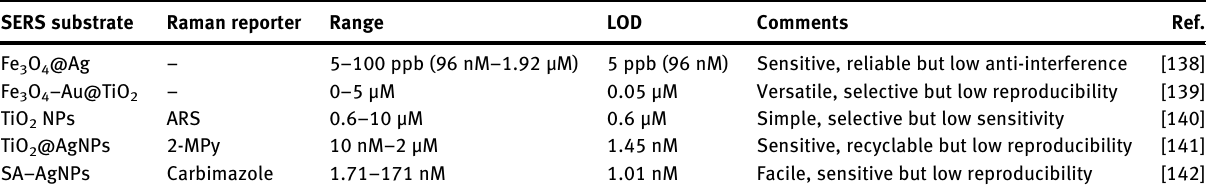
Table  : SERS-based methods for the determination of Cr(VI). SERS